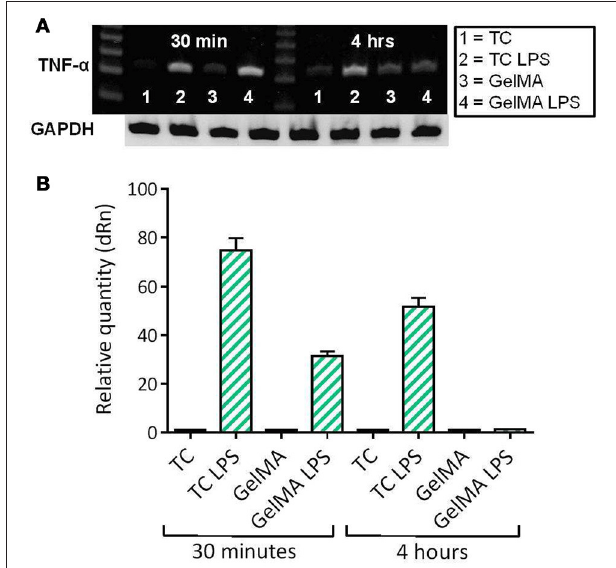
FIGURE 3 | LPS-induced TNF- α gene expression is down-regulated in PBMCs cultured on GelMA. (A) Measurement of TNF- α gene expression by conventional ethidium bromide gel-based RT PCR. After 30min in culture, the band intensity indicates TNF- α gene expression has increased as a result of LPS stimulation in both GelMA and TC cultures. At 4h, expression of TNF- α was maintained in the TC control, however, it was down-regulated in the GelMA condition. (B) Analysis of TNF- α gene expression by real time quantitative PCR. Thirty minute after LPS stimulation the relative quantity of TNF- α expression increased in GelMA and TC cultures. After 4h, up-regulation of TNF- α gene expression was maintained in TC cultures, however, LPS-induced TNF- α gene expression was attenuated in the presence of GelMA. 11 Ct Analysis normalized against GAPDH. Data shown is representative of 3 independent